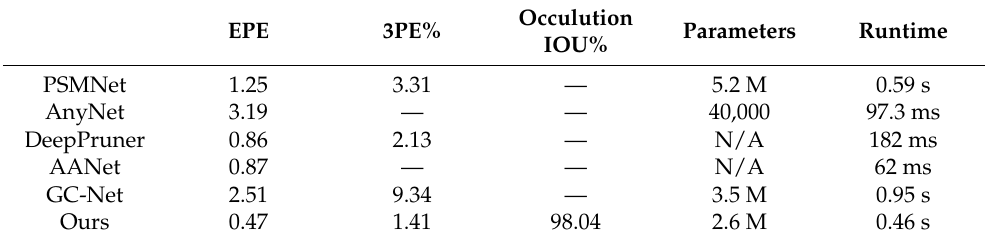
Table 2. Quantitative evaluation on the DispNet/FlowNet2.0